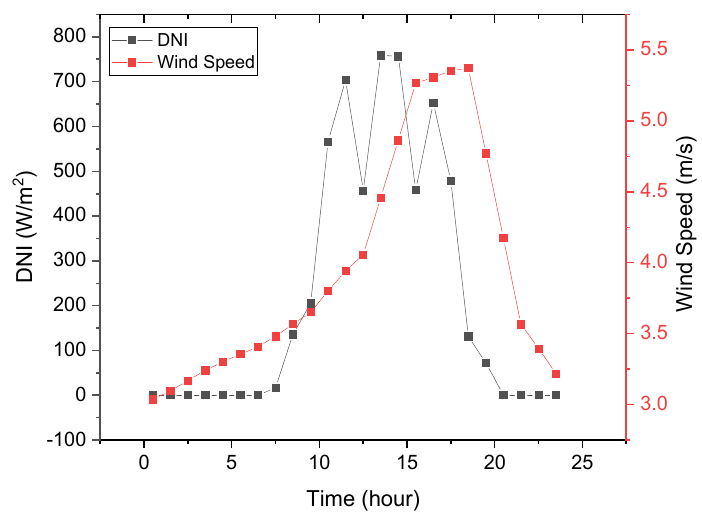
Figure 4. Hourly weather characteristics for the study area.